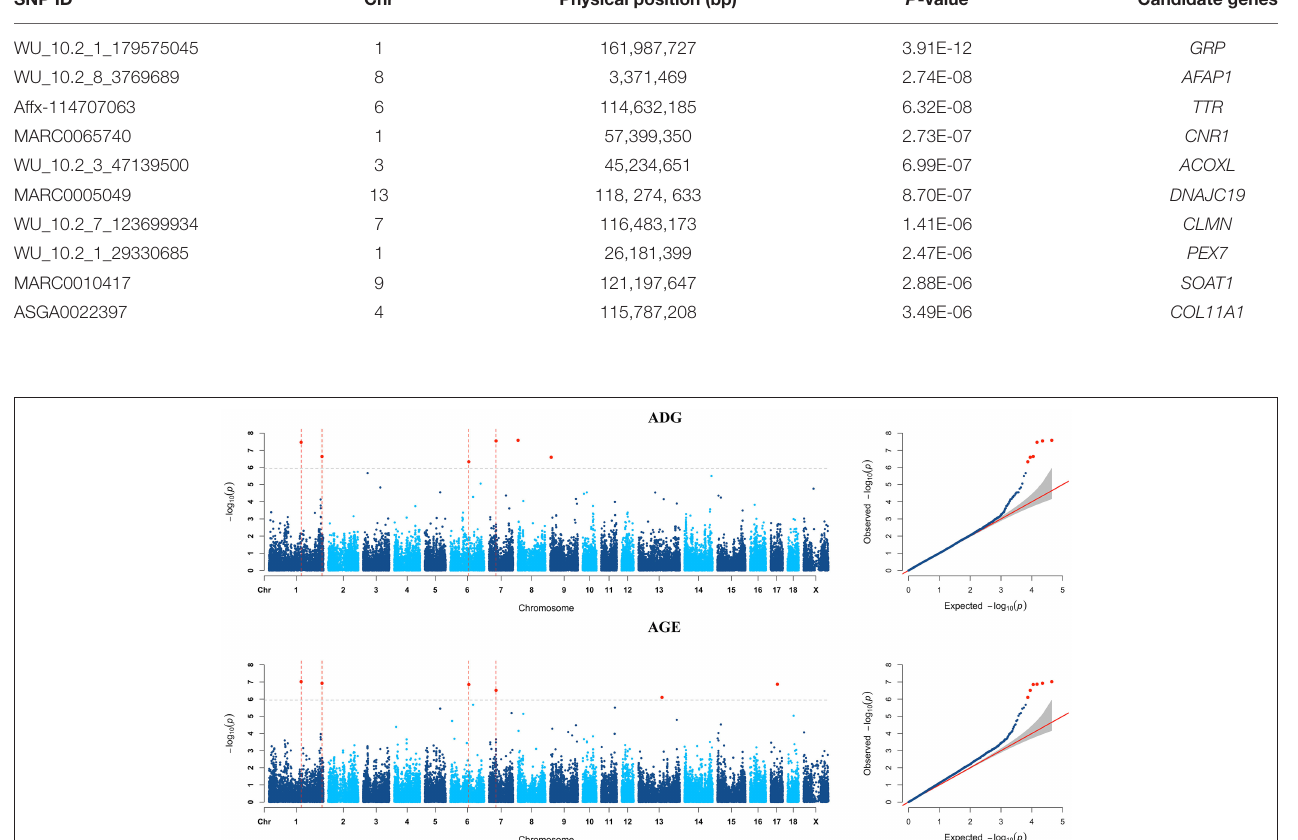
TABLE 5 | Summary information of top ten significant SNPs for AGE trait. SNP ID Chr Physical position (bp) P